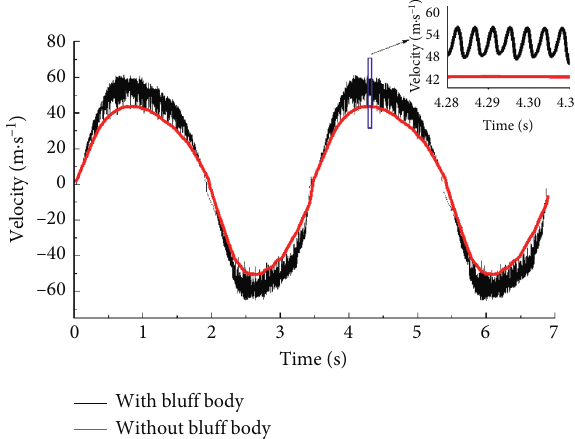
Figure 8: Comparison of the velocities at the outlet channel with and without the bluff